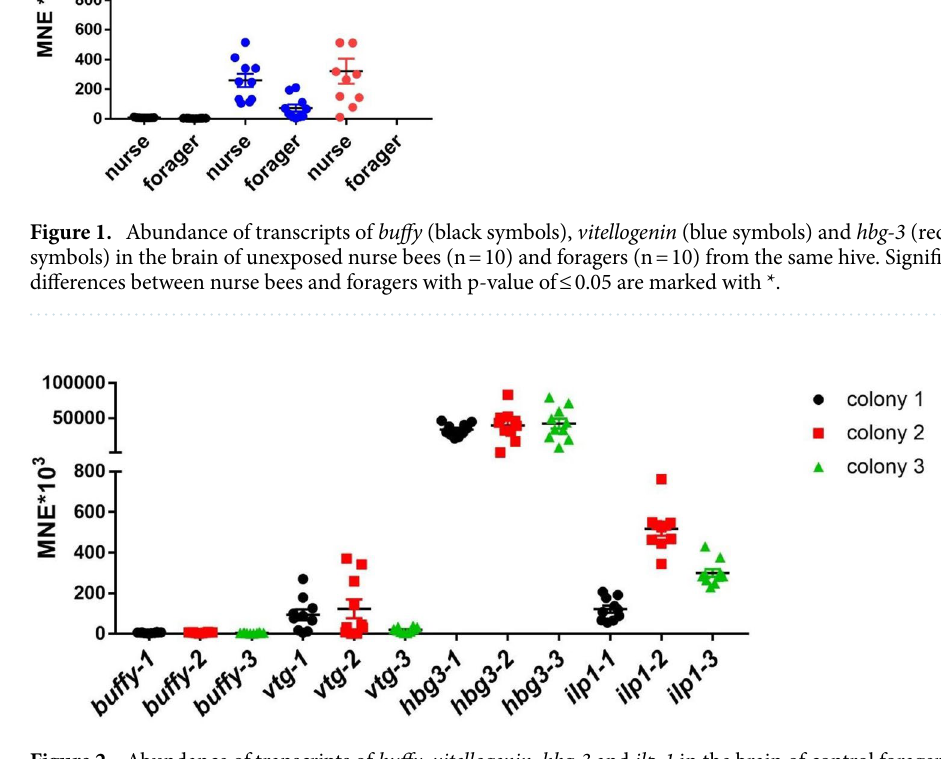
Figure 2. Abundance of transcripts of buffy , vitellogenin , hbg-3 and ilp-1 in the brain of control foragers (n = 10) of colony 1 (black symbols), colony 2 (red symbols) and colony 3 (green symbols). No significant differences were found for the expression of the four examined transcripts between the three different